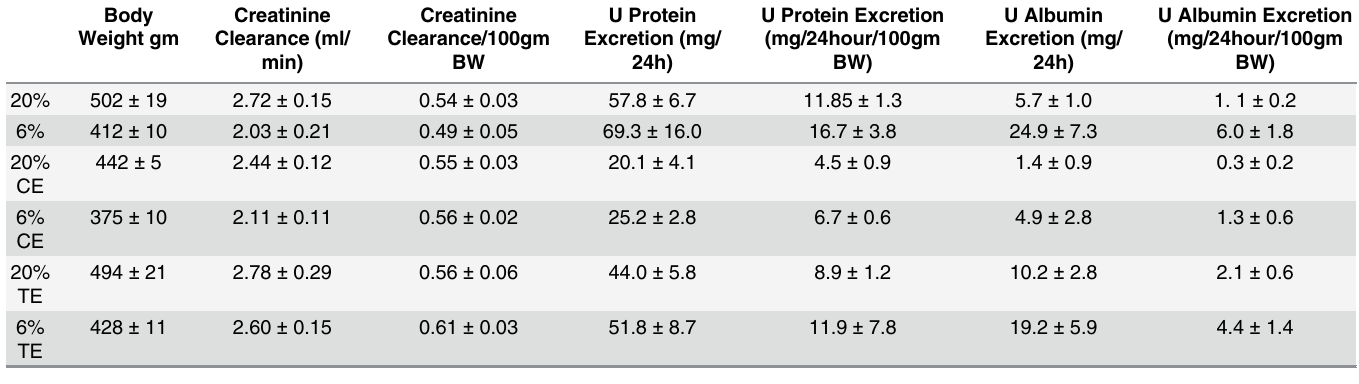
Table 2. Effect of Continuous or Transient Enalapril on Creatinine Clearance and Urinary Protein Excretion in Control and Programmed Rats. Body Weight